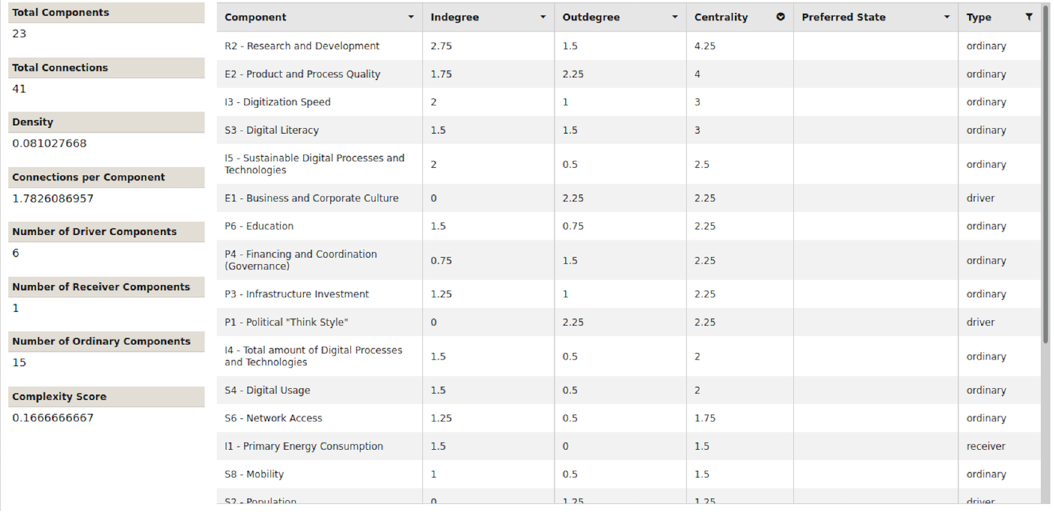
Figure 10. COVID-19 scenario (natural disaster). Network parameters and centrality (Screenshot from Mental Modeler Software).